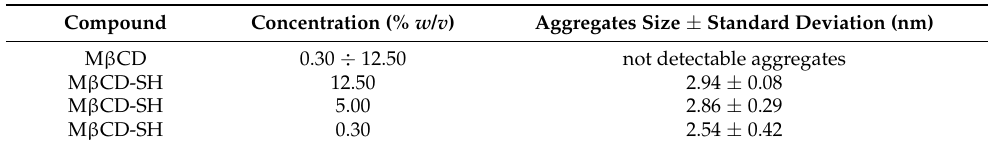
Table 3. Size of the nanometric aggregates spontaneously formed in water solution. Values ± standard